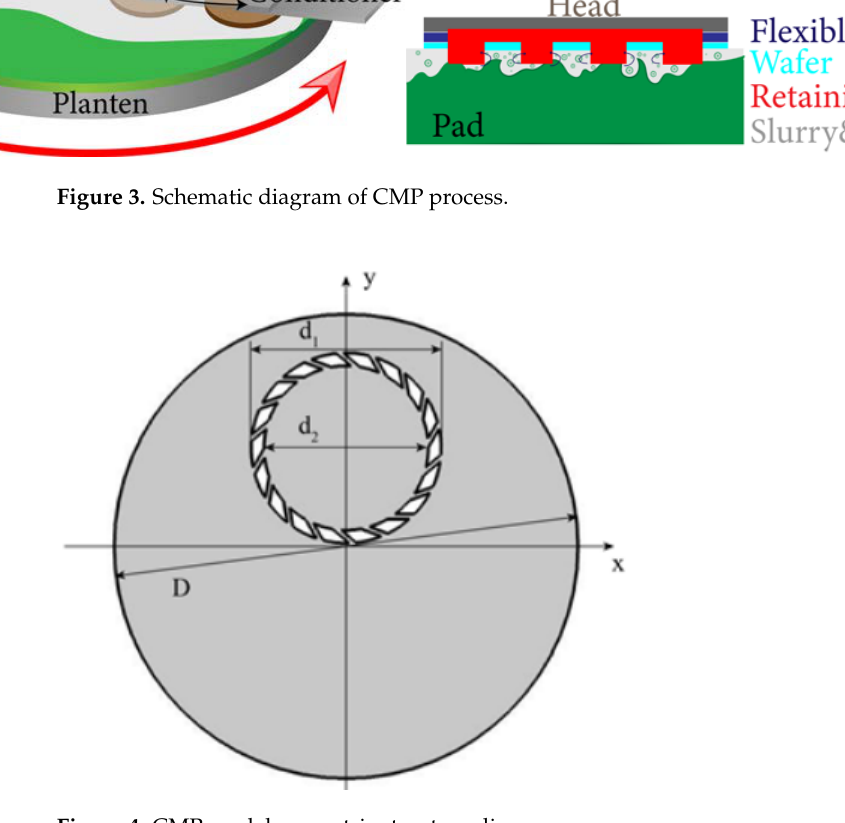
Figure 3. Schematic diagram of CMP process .